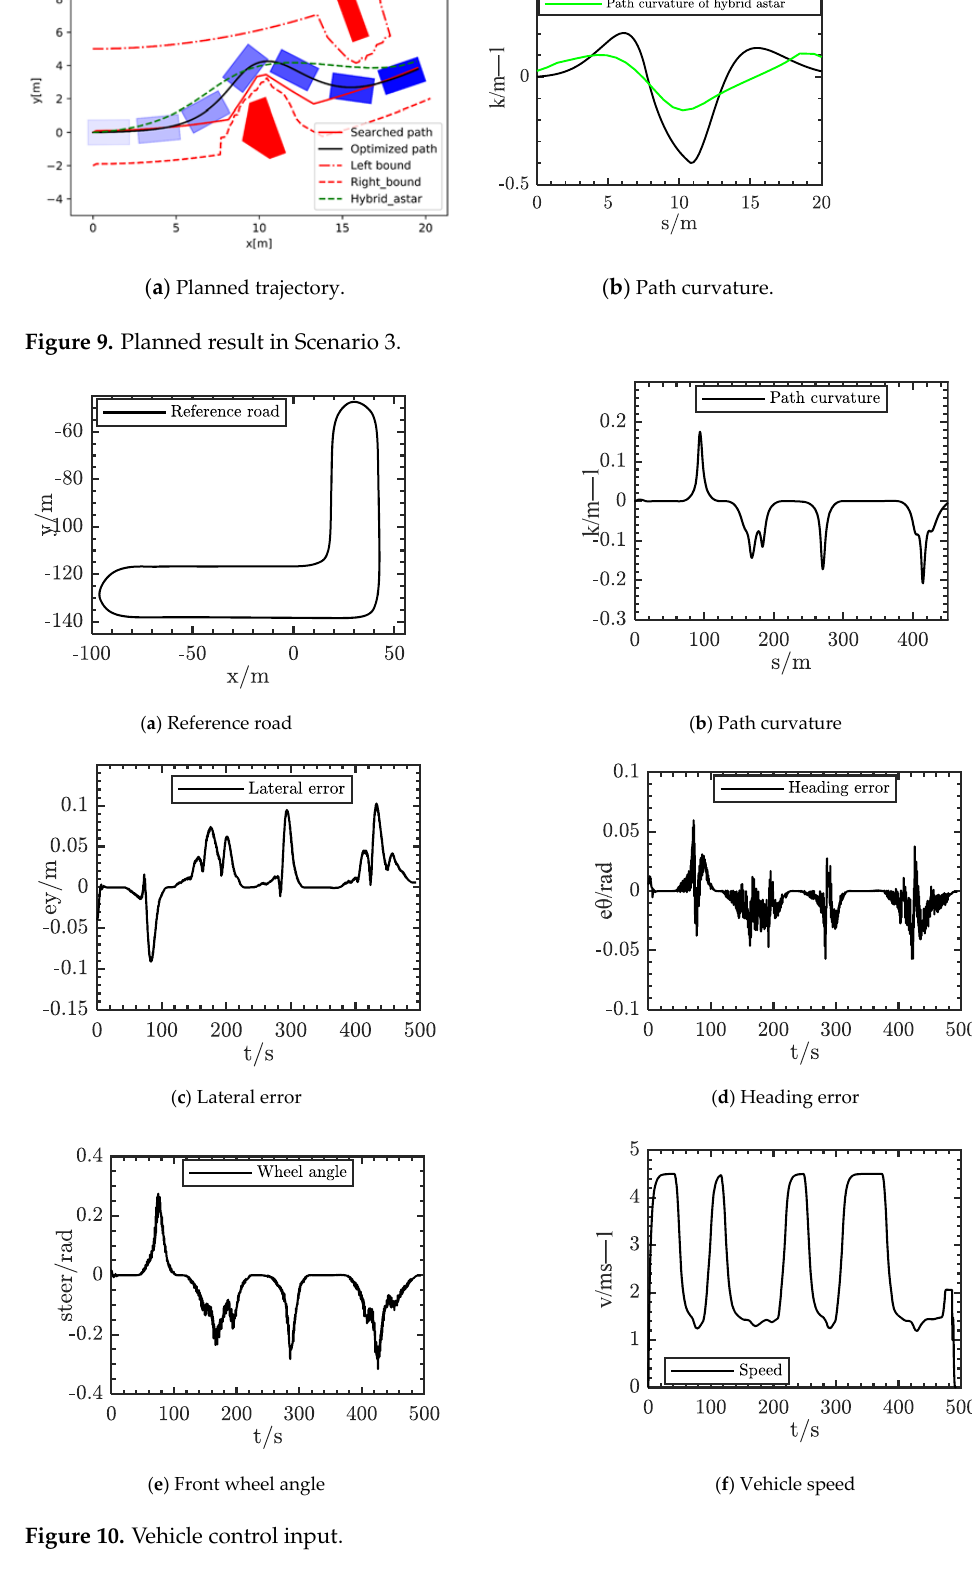
Figure 9. Planned result in Scenario 3.